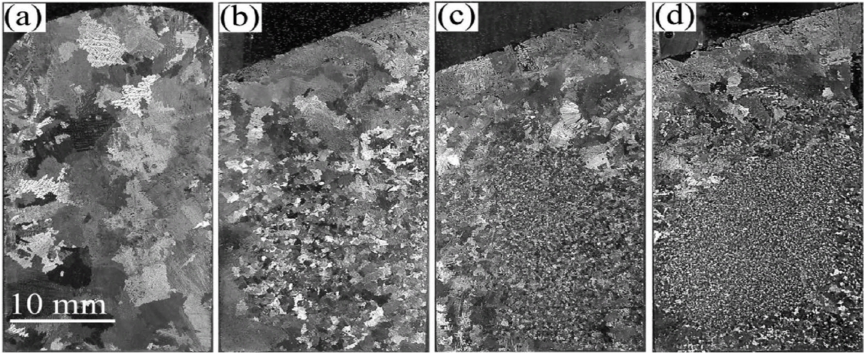
Figure 9. Cu-11 wt%Sn macrostructure at ( a ) G = 1, ( b ) G = 100, ( c ) G = 300, and ( d ) G = 600 [12].